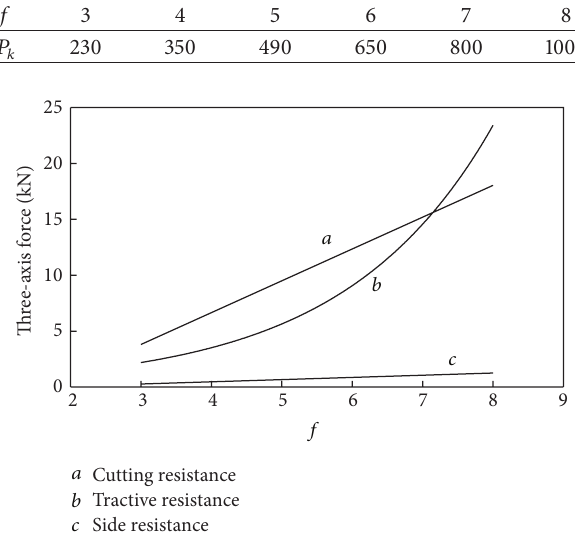
Figure 1: Relationship between three-axis force and 𝑓 .